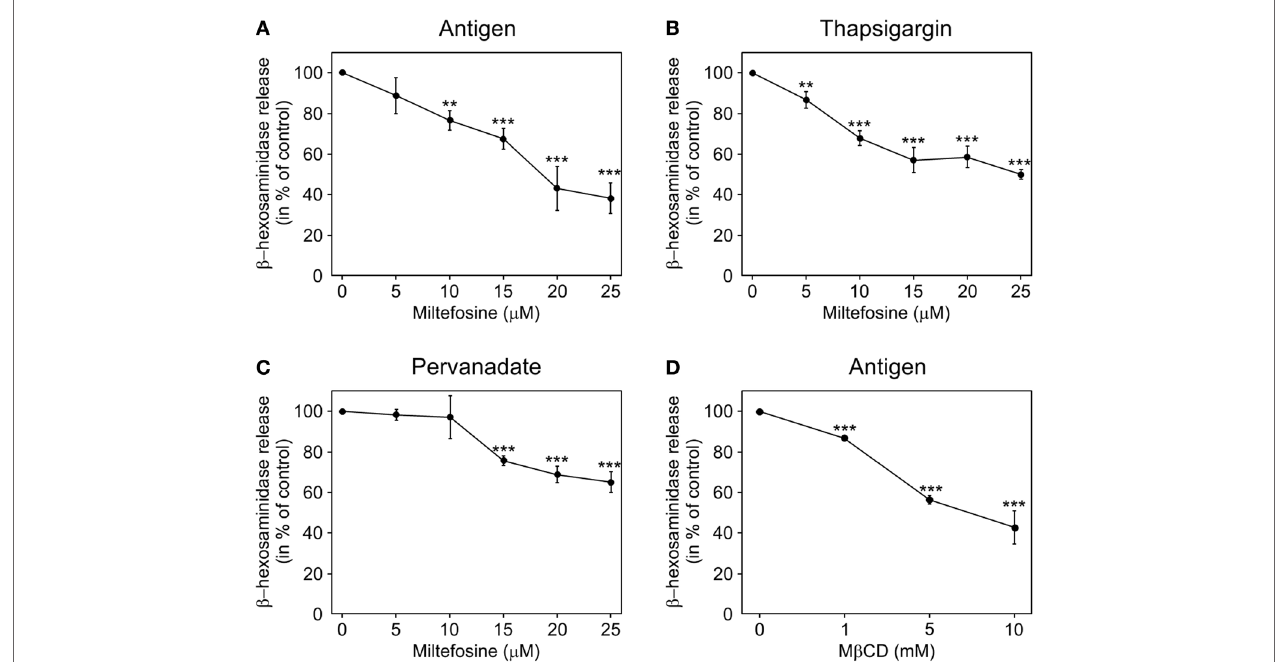
FigUre 1 | Miltefosine and methyl- β -cyclodextrin (M β CD) inhibit degranulation in activated bone marrow-derived mast cells (BMMCs). BMMCs pre-incubated with different concentrations of miltefosine (5–25 µM) (a–c) or M β CD (1–10 mM) (D) were activated and degranulation was measured by β -hexosaminidase release. (a,D) IgE-sensitized cells were activated by high affinity IgE receptor aggregation with Ag. (B) Cells activated with thapsigargin. (c) Cells activated with pervanadate. Values represent mean ± SD ( n = 3); ** p < 0.01 and *** p <